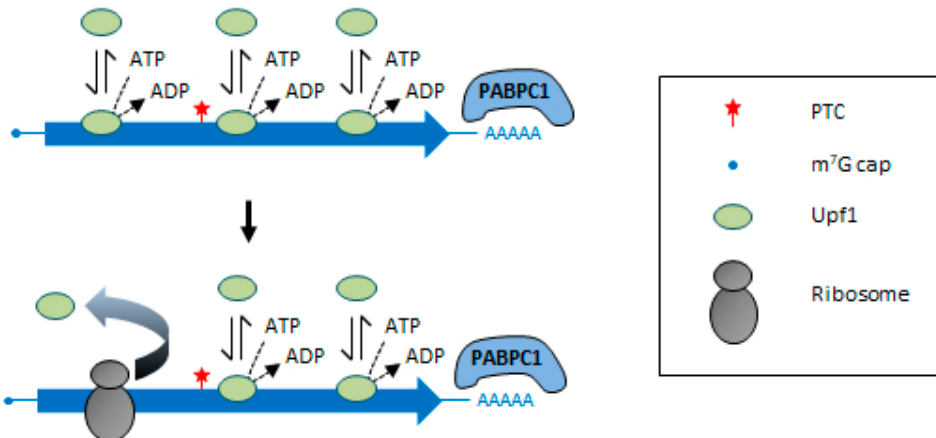
Figure 2. Model of translation-dependent displacement of Upf1 from the mRNA coding region. Upf1 binds promiscuously to any accessible RNA (including NMD non-targets), independently of translation. ATP hydrolysis promotes Upf1 dissociation from non-target RNA regions. Upf1 is also displaced from the coding region by the translating ribosome. This model implies that NMD substrate selection occurs after Upf1 associates with the RNA.